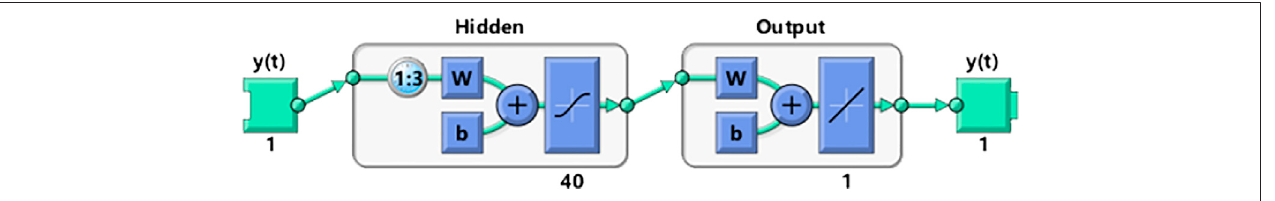
FIGURE 1 | Schematic diagram of the NAR algorithm